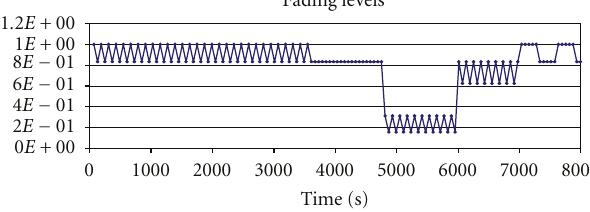
Figure 4: Fading: real fading trace (bandwidth reduction factor φ ( t )) used in the simulations, taken from